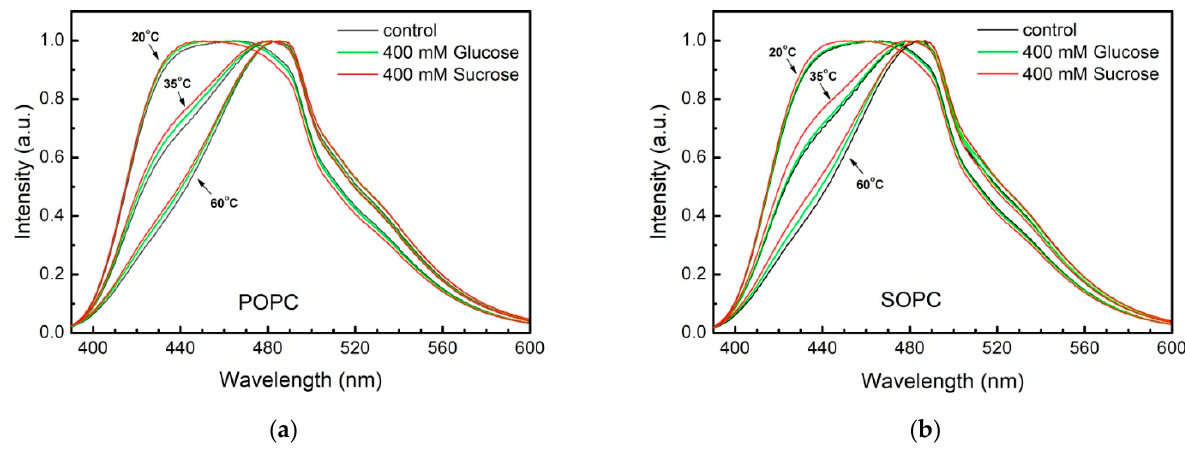
Figure 5. Laurdan intensity profiles from ( a ) POPC and ( b ) SOPC LUVs in water (control) and in 400 mmol/L glucose or sucrose scanned at 20, 35, and 60 °C.